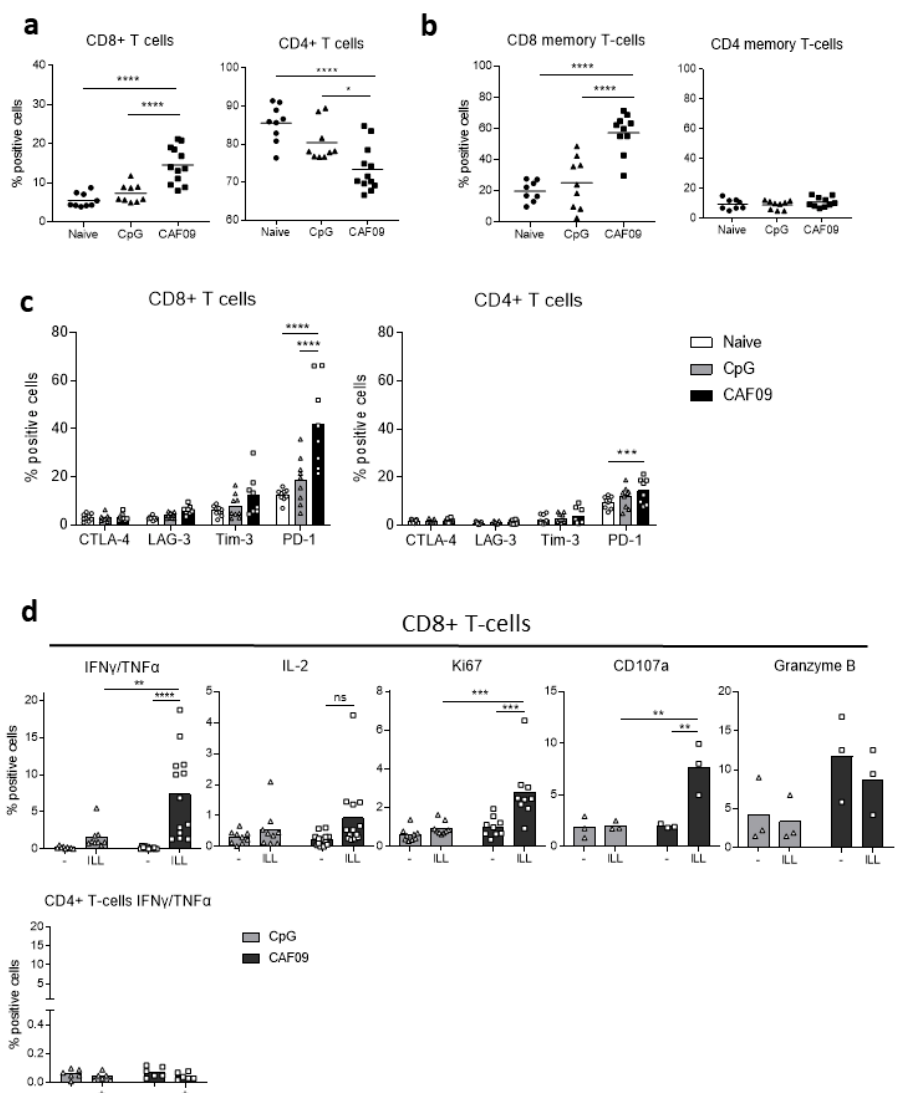
Figure 4. The PAP42mer-mutated vaccine promotes the expansion of effector/memory CD8 + Tcells and induces ILL-specific CD8 + T cells with a secretory and degranulating phenotype. HHDII/DR1 mice were immunized on days 1, 15, and 29 with either the CpG or the CAF09 ® -based mutated hPAP 42 mer vaccine. Seven days after the last immunization, splenocytes were isolated from spleens and incubated with a murine FcR block and stained with surface Abs for flow cytometry analysis indicating ( a ) proportion of T cells, ( b ) proportion of effector memory T cells, and ( c ) expression of inhibitory receptors. Splenocytes were stimulated with either ILL 9 mer alone or with VSI 15 mer for 6 h at 37 ◦ C, incubated with a murine FcR block, stained with surface mAbs, fixed, and permeabilized and stained with intracellular mAbs for flow cytometry analysis indicating ( d ) cytokine secretion, proliferation, and degranulation. The CAF09 ® -based vaccine increased the proportion of CD8 + T cells and of CD8 + memory T cells and induced the expression of PD-1. The vaccine also induced the proliferation, cytokine secretion, and degranulation of CD8 + T cells upon stimulation. Bars represent the mean percentage of positive cells and the error bars represent the SD. One to four independent experiments were performed ( n = 3 to 12 animals per test group). A significant difference in the proportion of positive cells between immunization groups was determined using a two-way ANOVA comparison test. The p -values were annotated as follows: * p < 0.05, ** p < 0.01, *** p < 0.001, **** p <